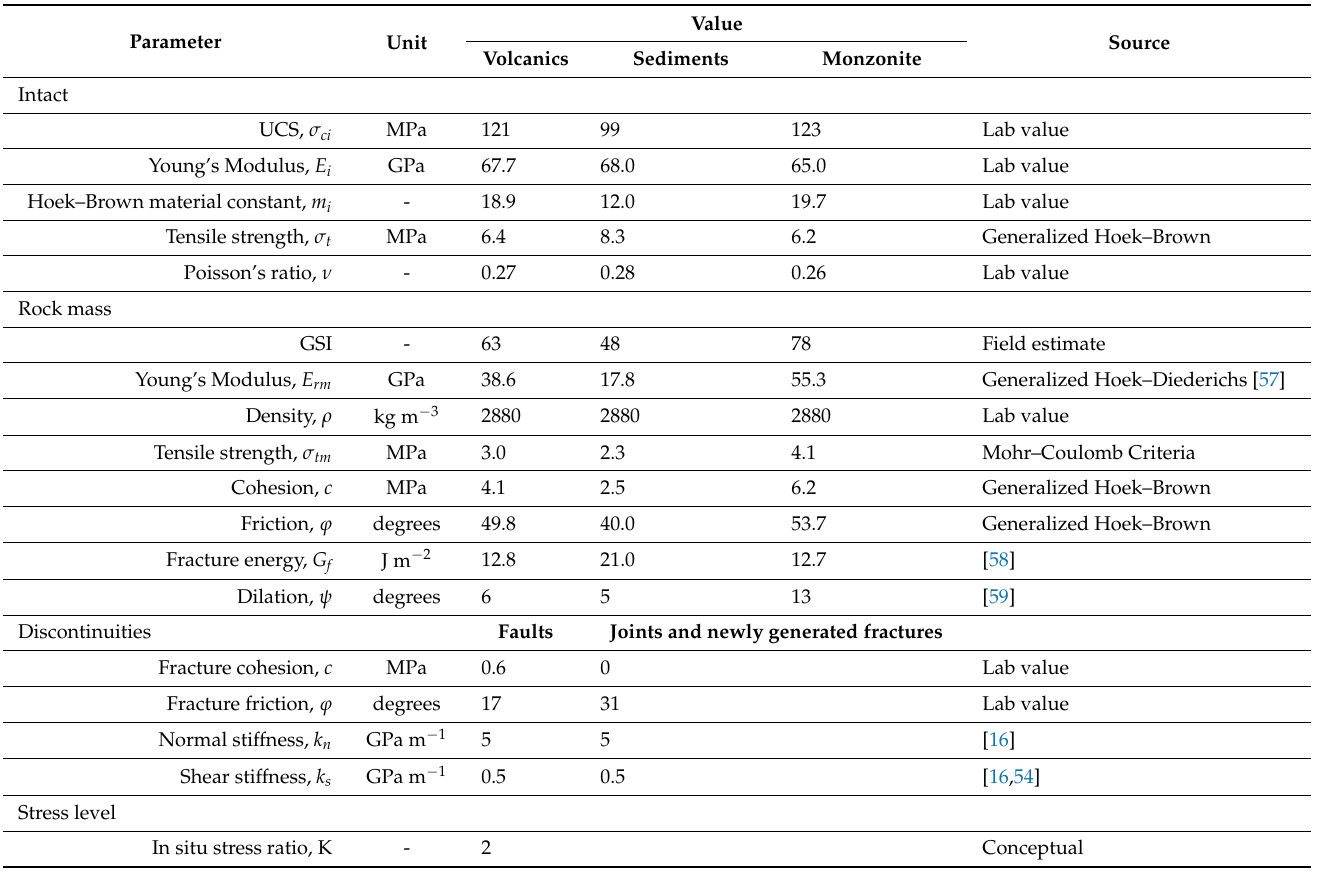
Table 3. Geotechnical domain properties and FDEM modelling input